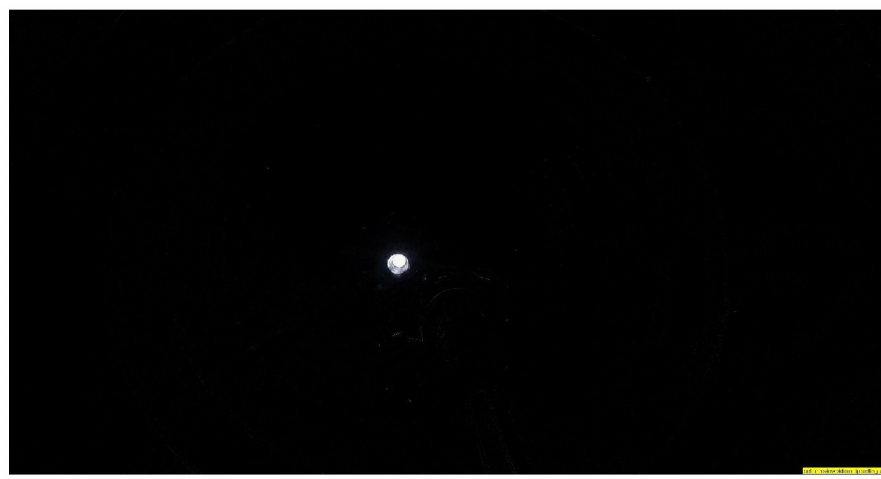
Figure 6. Image capture from Tracker showing horizontal movement of a puff of “smoke” along the underside of the manhole cover. The puff is visible as a faint, small cloud of white at the 7 o’clock position just beyond the opening. Application of the “baseline subtract” function increased the visibility of the puff to the level needed for identification and measurement of distance